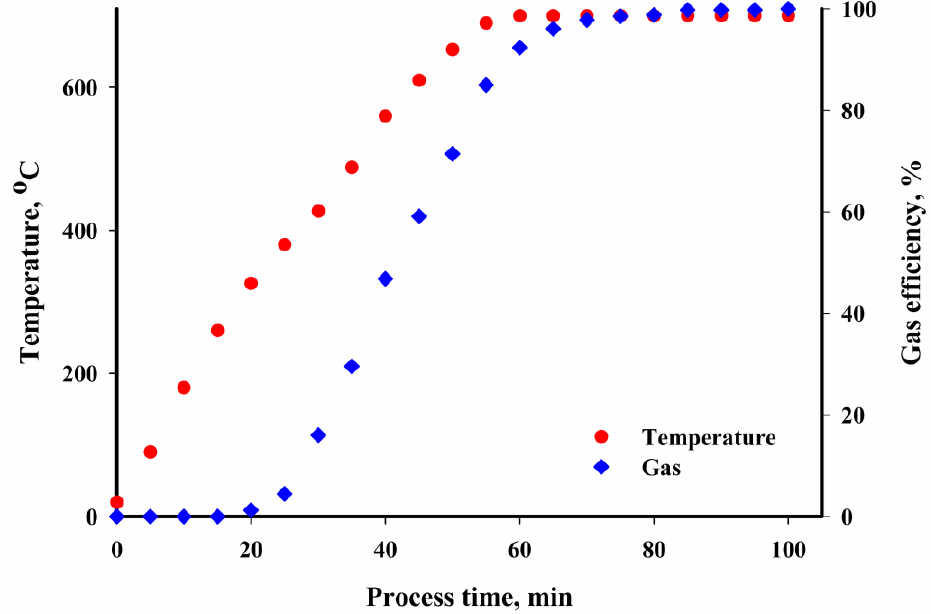
Figure 3. Dynamics of the gas evolution process. Table 4. Pyrolysis gas composition (N 2